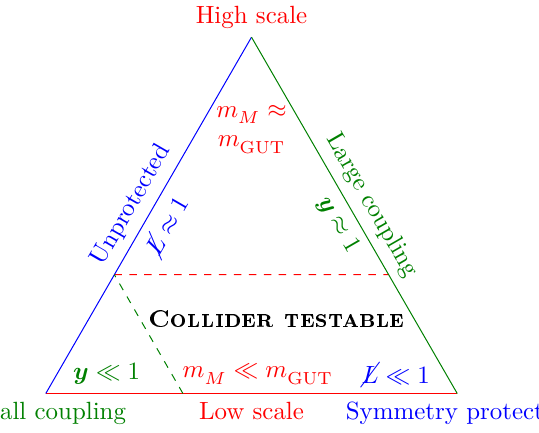
Figure 2 . Depiction of the three limiting seesaw regimes described in the text. The phenomenolog- ically accessible parameter space of low-scale seesaws with large enough coupling is connected to the symmetry-protected corner and indicated by dashed